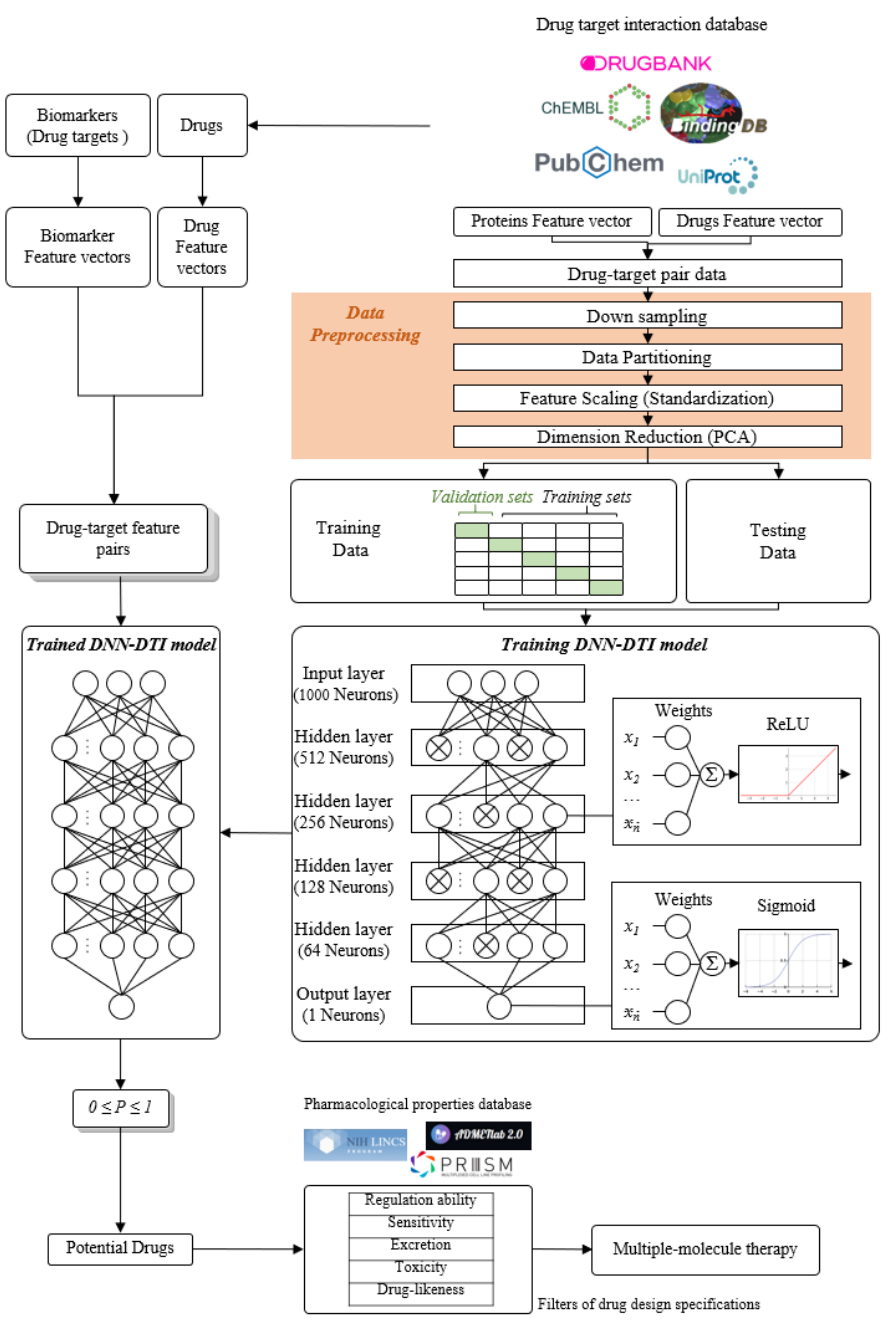
Figure 5. The flowchart for multiple-molecule drug design of COVID-19-associated ARDS and non-viral ARDS. In the right column, the drug–target interaction data are obtained from drug–target interaction databases to construct drug-target pair data. After data preprocessing, these data are divided into training data and testing data to train the DNN-DTI model for the trained DNN-DTI model in the left column. In the left column, the feature vectors of biomarkers and the feature vectors of drugs from drug–target interaction databases consist of drug-target feature pairs and are mounted into the trained DNN-DTI model to predict potential drugs for these biomarkers (drug targets). Then, these potential drugs are filtered by five drug design specifications to obtain candidate drugs as multiple-molecule drugs for COVID-19-associated ARDS and non-viral